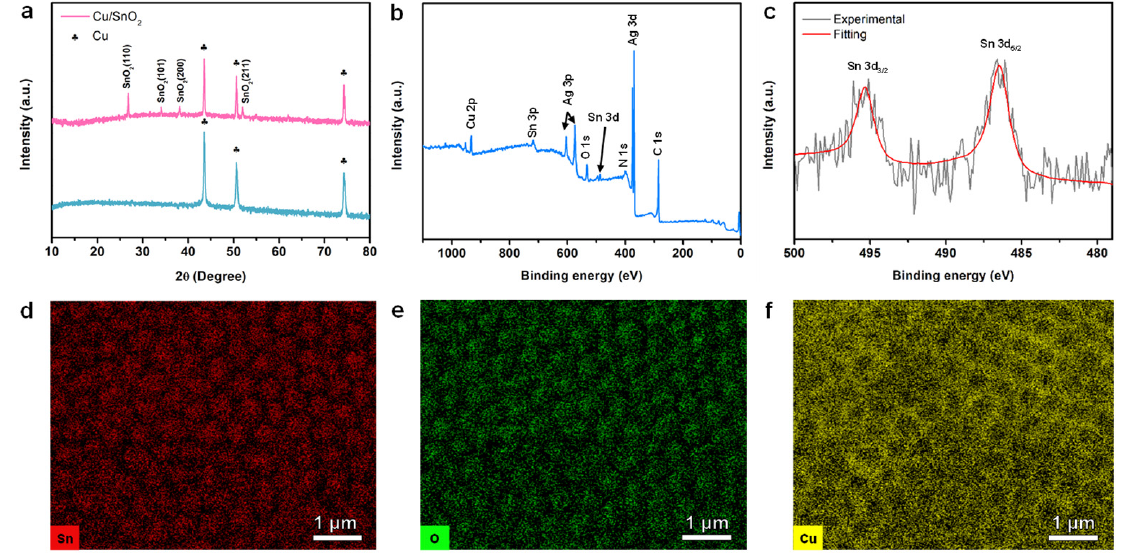
Figure 2. ( a ) XRD patterns of bare and SnO 2 -coated Cu foils; ( b ) wide-range XPS spectrum of SnO 2 nanoarray; ( c ) high-resolution Sn 3d XPS spectrum; and elemental maps of ( d ) Sn, ( e ) O and ( f ) Cu from SnO 2 nanoarray.